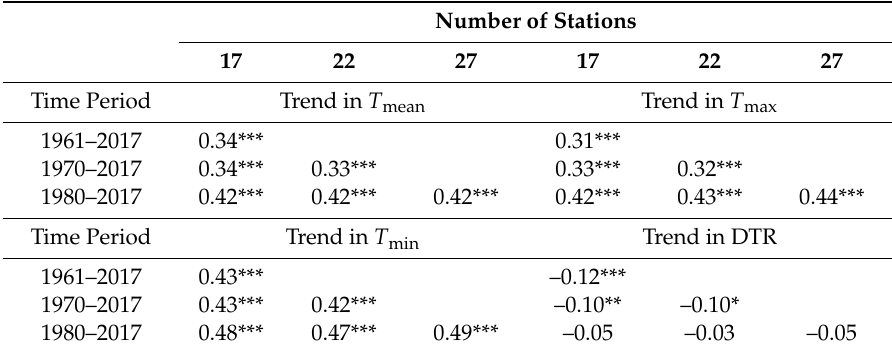
Table 1. Trends of regional temperature on the mid-south of Tibetan Plateau for di ff erent time periods ( ◦ C / decade).